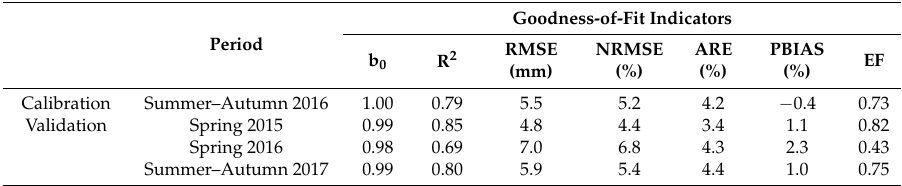
Table 7. Goodness-of-fit indicators for the treatment relative to frequent cuttings with CGDD of 124 ◦ C when adopting a single K cb = 0.80.